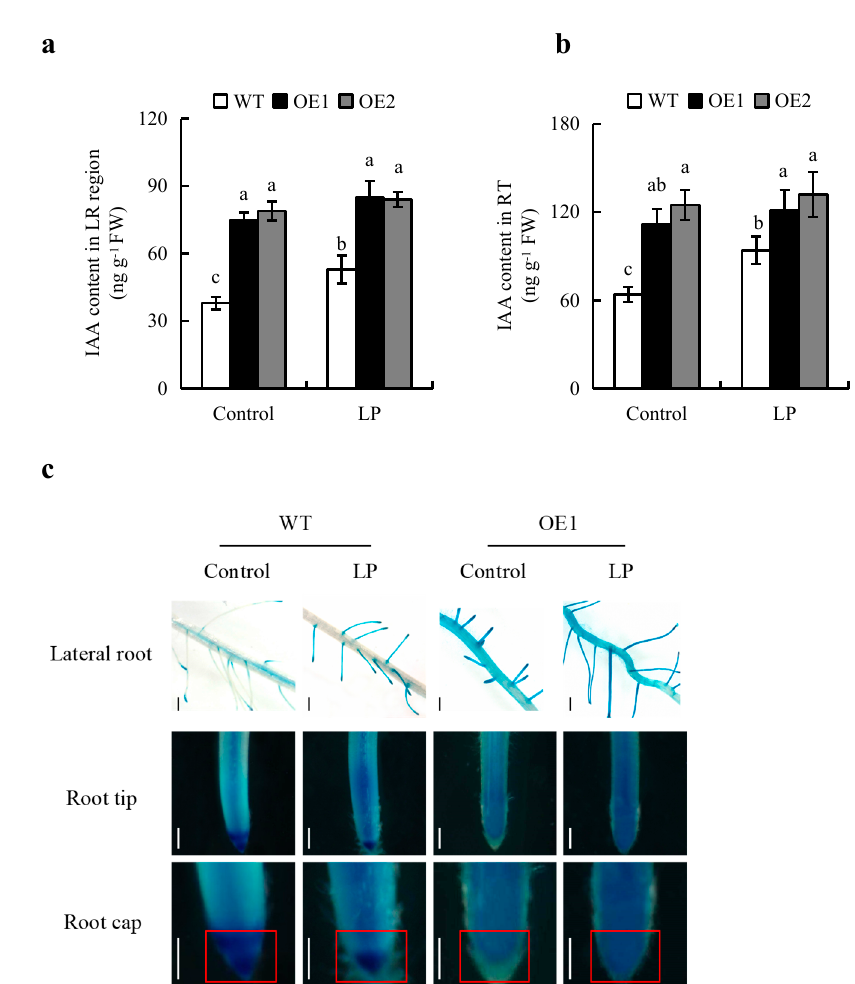
Figure 2. IAA content and histochemical localization of DR5::GUS in the wild type (WT, Nipponbare) and the overexpression of OsPIN2 transgenic plants (OE1 / OE2). Seedlings were grown in hydroponic media containing normal nutrition (control, 300 µ M P) or low P (LP, 10 µ M) for 7 d. ( a , b ), IAA concentration in lateral root (LR) ( a ) and root tip (RT) ( b ). ( c ), The expression of DR5::GUS . Bar = 1mm. d = days. Data are means ± SE and bars with di ff erent letters in the same root zone indicate significant di ff erence at p < 0.05 tested with ANOVA. The red boxes indicate the root cap region. All experiments included three independent biological replicates.